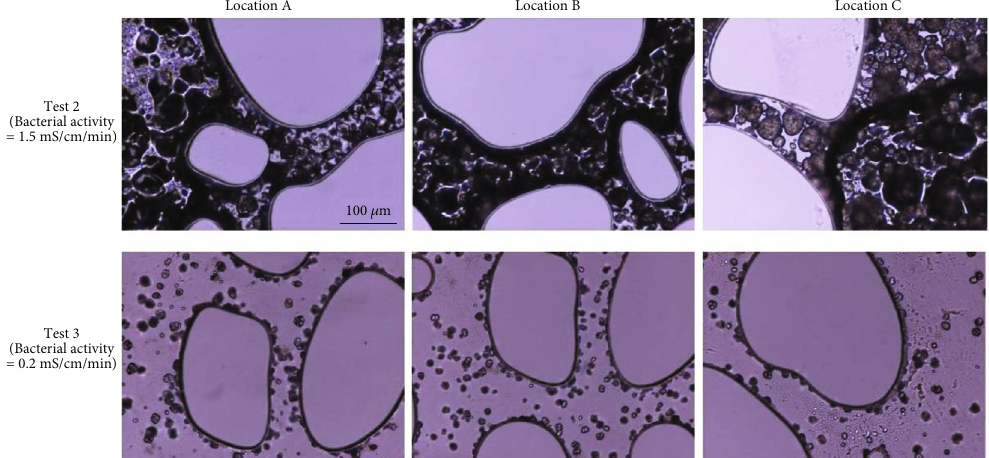
Figure 8: Comparative results of the fi nal treatment e ff ects in Tests 2 and 3 showing the in fl uence of bacterial activity on the MICP process.